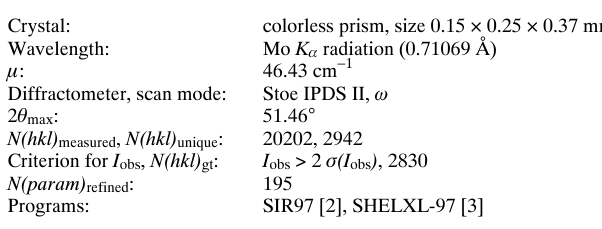
Table 1. D a t a collection a nd h a ndling.